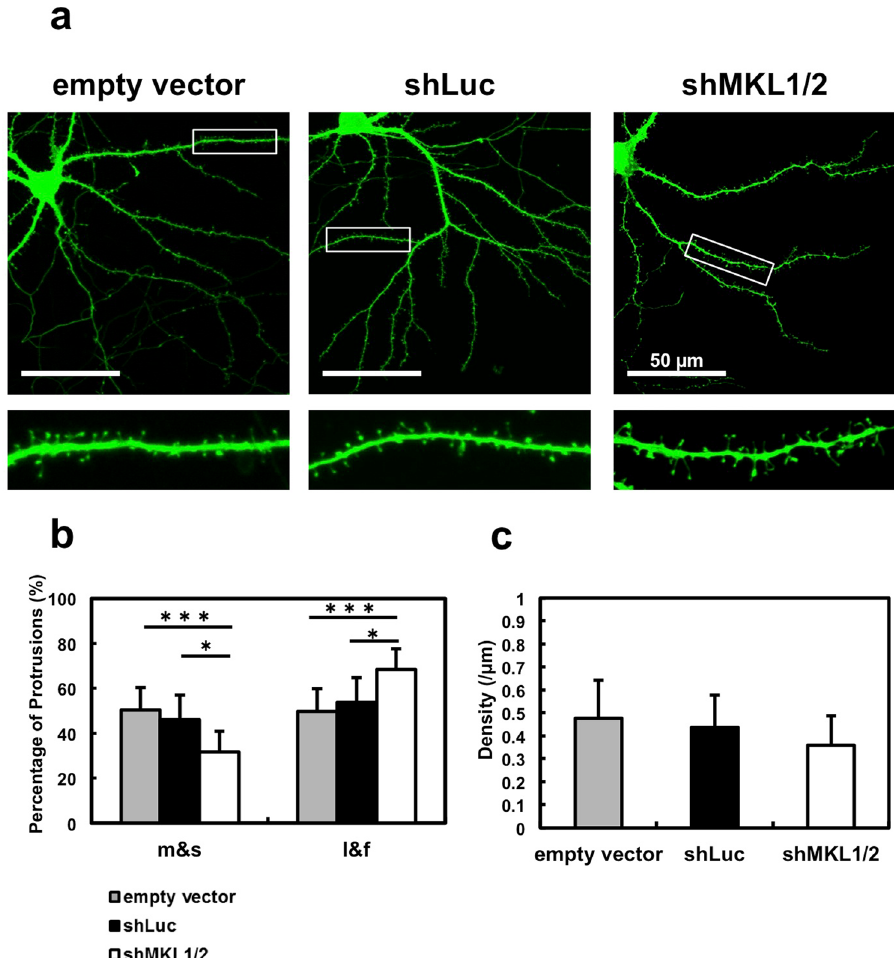
Figure 6. Effect of MKL knock-down on dendritic spine morphology and density in hippocampal neurons. ( a ) Spine morphology of hippocampal neurons transfected with pSynapsinGFP (0.5 μ g/well) and 1 μ g/well of pSuper (empty vector), shLuc, or sh MKL1/2 . Transfection was performed at 9 or 10 days in vitro (DIV). Neurons (DIV 16) were immunostained using anti-GFP antibody. Dendritic spine morphology was analysed using the semi- automated SpineMagick software. ( b ) The percentage of protrusions clustered into four categories: mushroom, stubby, long, and filopodia (m and s: mushroom or stubby; l and f: long or filopodia). ( c ) Dendritic spine density. Graphs show mean ± S.D. from four independent experiments. The statistical significance of differences was analysed by ANOVA with Dunn’s multiple comparisons test. * p < 0.05, *** p <